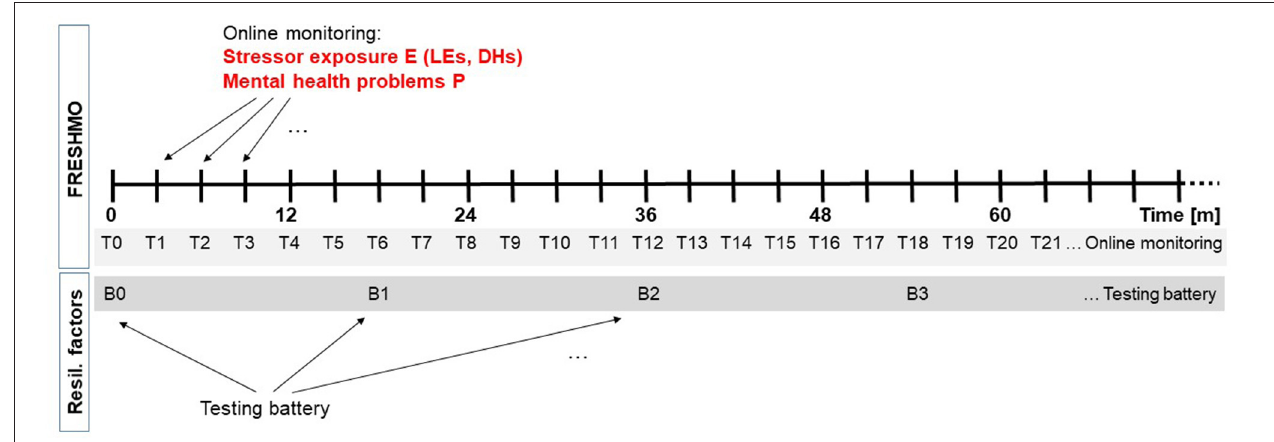
FIGURE 1 | Example design scheme employing the FRESHMO paradigm in combination with repeated assessment of resilience factors. Every 3 months (T1, T2, …), exposure to macrostressors (life events, LEs) and microstressors (daily hassles, DHs) is assessed via self-report using online questionnaires. At the same online monitoring surveys, mental health problems P are reported. Every 1.5 years (B0, B1, B2, …), subjects complete a testing battery for resilience